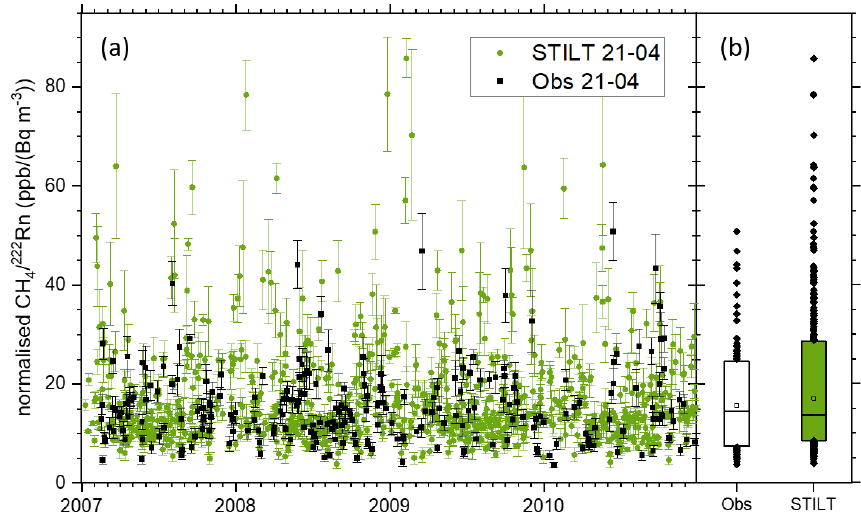
Figure 8. (a) Variability of observed (Obs, black squares) and simulated (STILT, green dots) nighttime CH 4 / 222 Rn slopes from 2007 to 2010. (b) The distributions of all slopes with the boxes including 80% of the data, the open squares representing the mean, and the horizontal lines the median values. Note that for the further discussion we excluded the three modelled values > 70ppb ( Bqm − 3 ) − 1